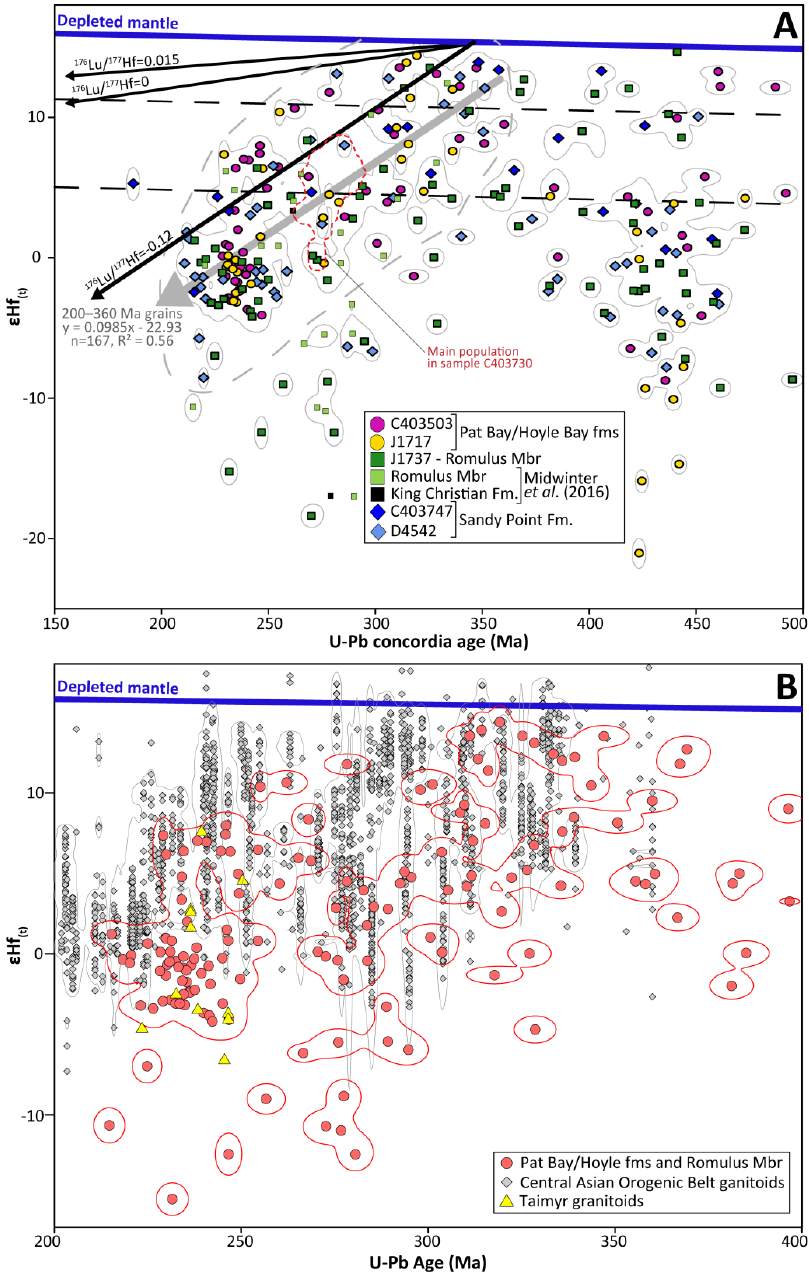
Figure 12. ( A ) U–Pb age versus ε Hf (t) scatter plot showing data from the Pat Bay, Hoyle Bay, Heiberg, King Christian and Sandy point formations. Detrital zircon Hf isotope data from Midwinter et al. [33] were reprocessed using U–Pb concordia ages. Analyses with U–Pb ages >10% discordant are not shown. ( B ) U–Pb age versus ε Hf (t) scatter plot showing data from Late Triassic strata of the Sverdrup Basin (this study and [33]), Carboniferous to Triassic granitoids of the Central Asian Orogenic Belt [109–136] and Triassic granitoids on Taimyr [137,138]. Data from the Taimyr granitoids are whole-rock ε Nd (t) data are converted to approximate ε Hf (t) values using the ε Nd– ε Hf terrestrial array relationship of Vervoort et al. [103]. In both plots, the thin bands surrounding data points are two-dimensional probability distributions drawn from the data and their respective analytical uncertainties in R using code modified from Sircombe [107]; they are drawn at the 2s confidence level. The depleted mantle trend is drawn assuming a present-day composition of 176 Lu/ 177 Hf = 0.0384 and 176 Hf/ 177 Hf = 0.28325 [108]. Mbr = member; Fm/fms = Formation/formations.